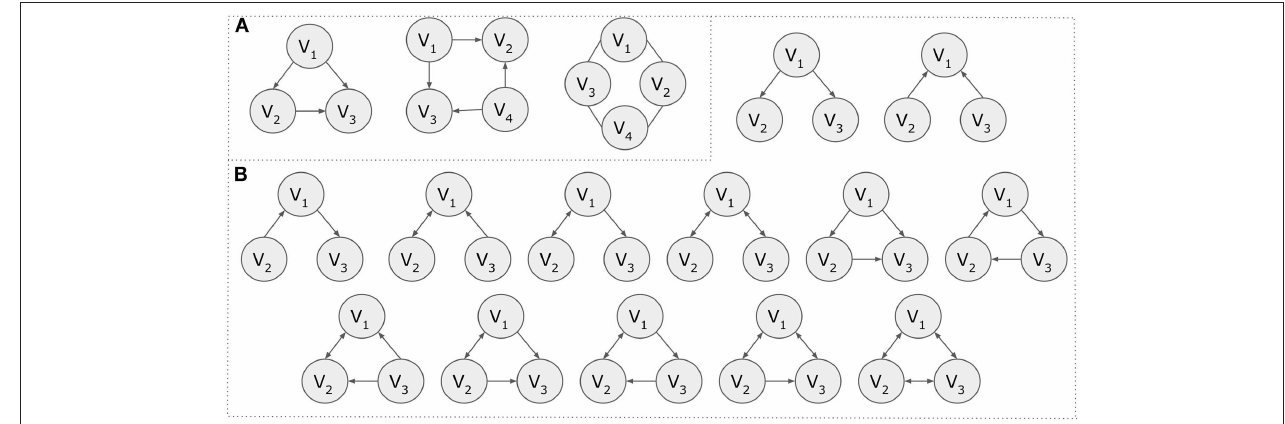
FIGURE 4 | Motifs. (A) Motif examples of three and four nodes. (B) The 13 possible directed motifs using three